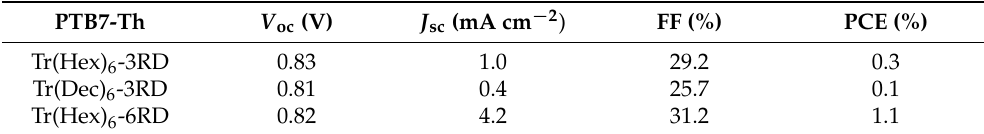
Figure 5. J–V characteristics curves of fabricated OSCs devices based on PTB7-Th: truxene-centered SMAs ( a ), and external quantum efficiency (EQE) of PTB7-Th:Tr(Hex) 6 -6RD ( b ). Table 2. Photovoltaic parameters of PTB7-Th: truxene-centered SMAs devices.